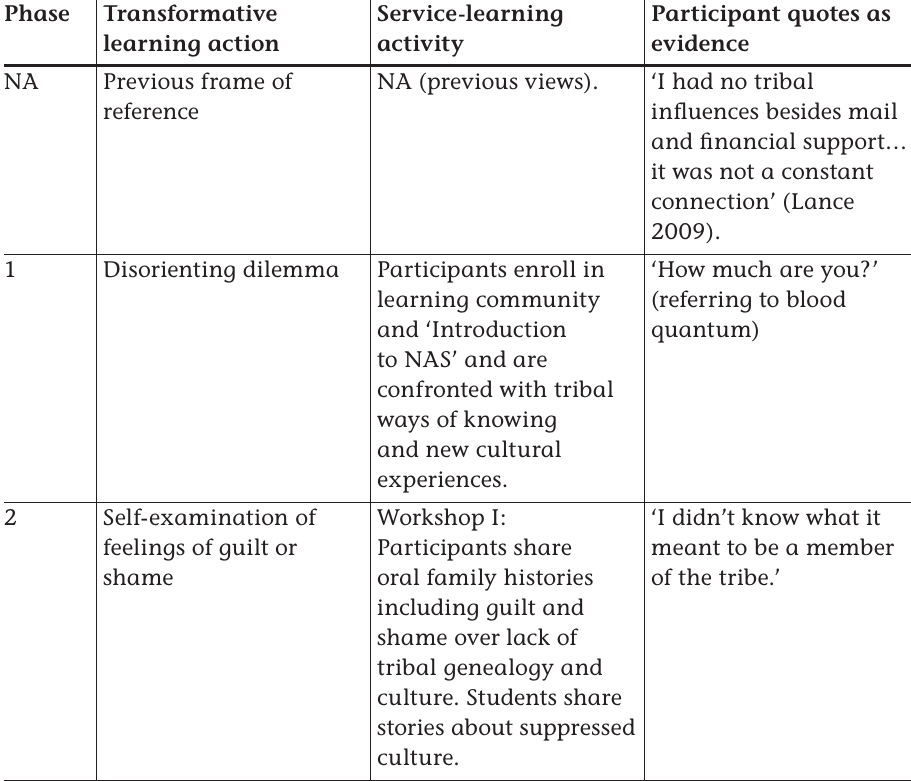
Table 1: ‘Ten Phases of Transformative Learning & Corresponding Service- Learning Activity’, adapted from Kitchenham